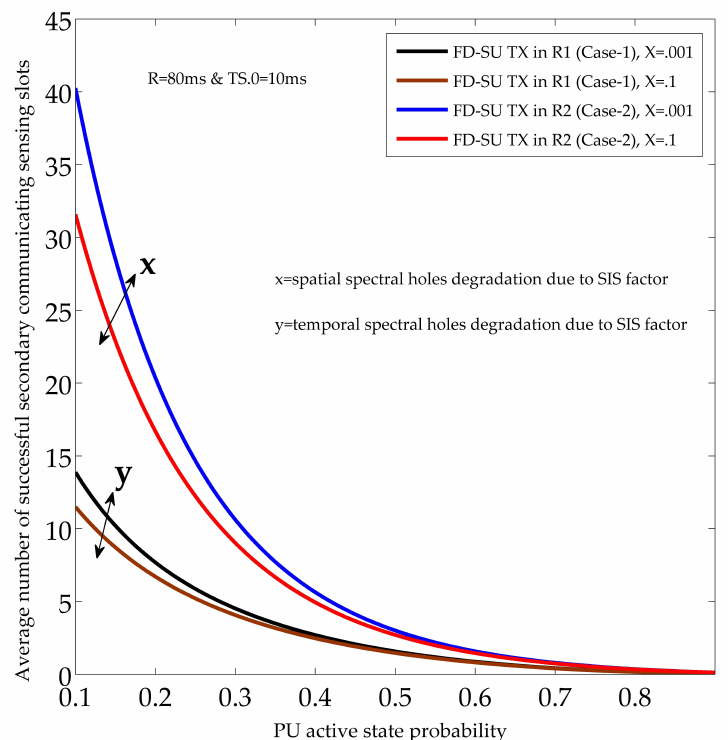
Figure 9. Average number of secondary communicating sensing slots with different PU active state probabilities and SIS factors (at different quality of service (QoS)